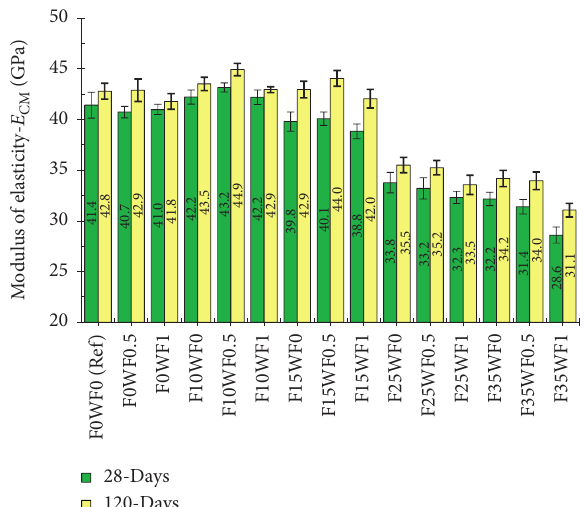
Figure 8: Effect of different combinations of WSF and FA on the (E)